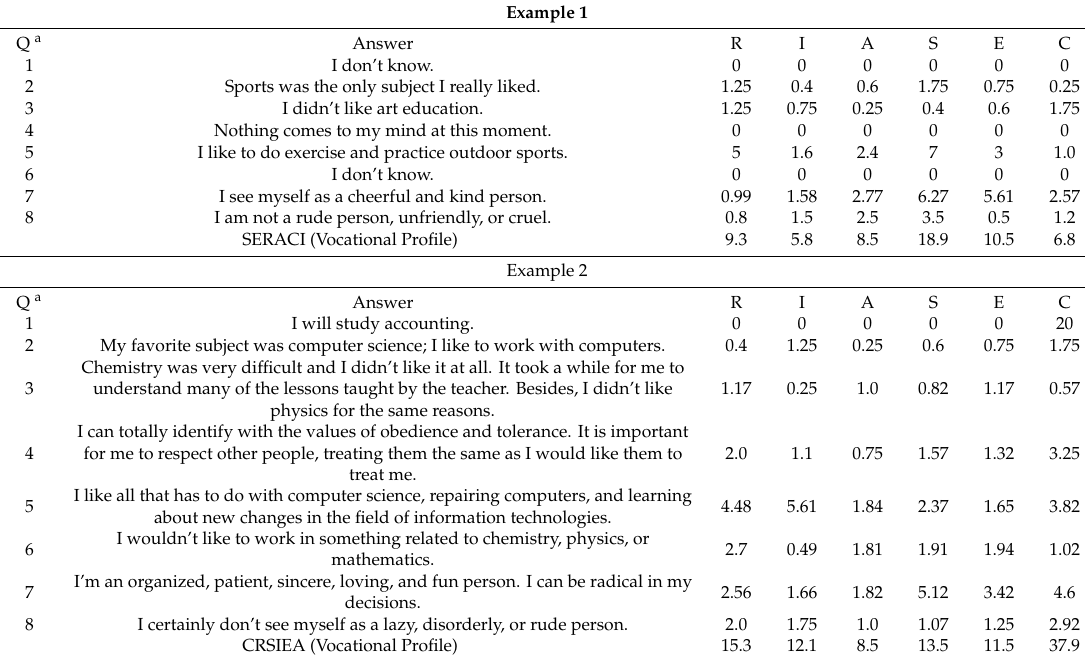
Table 13. Results for vocational profile evaluation.